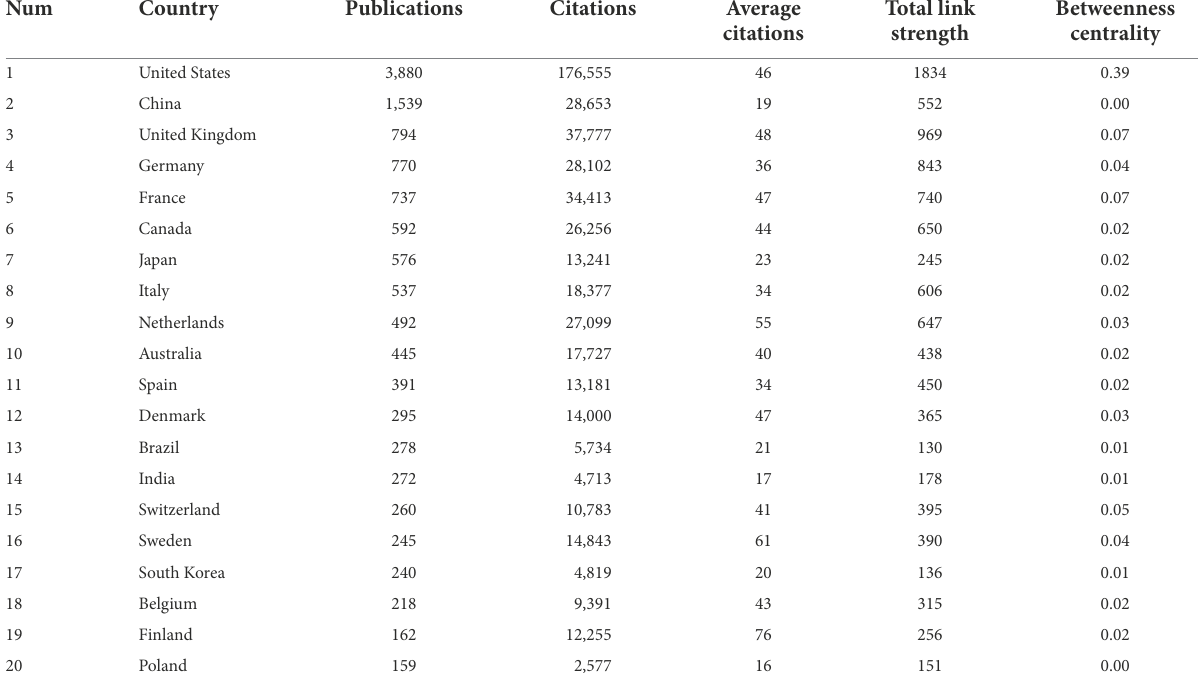
TABLE 1 Characteristics of the top 20 countries with the most publications.